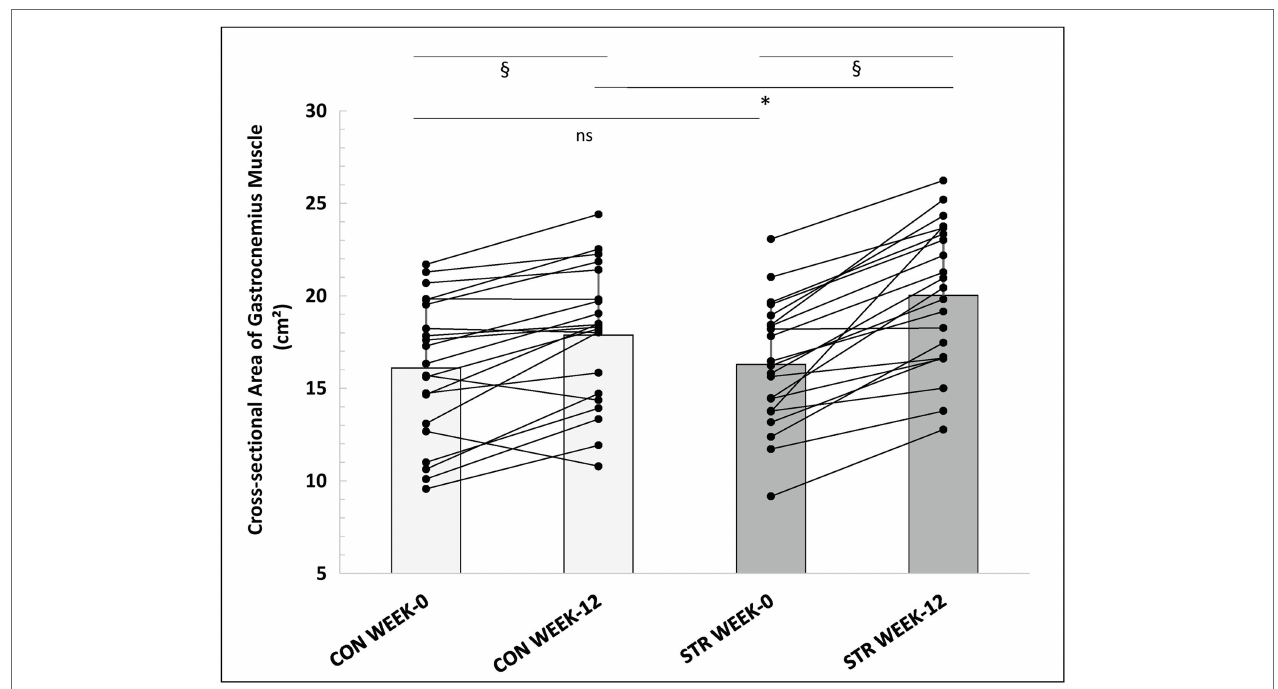
FIGURE 7 | Individualized values of gastrocnemius muscle anatomical CSA (sum of gastrocnemius medialis and lateralis) of the stretched and control legs, at week-0 and week-12. *: p < 0.01 from the corresponding control leg value; §: p < 0.05 from the corresponding pre-intervention value to post-intervention value; CON, control leg; STR, stretched